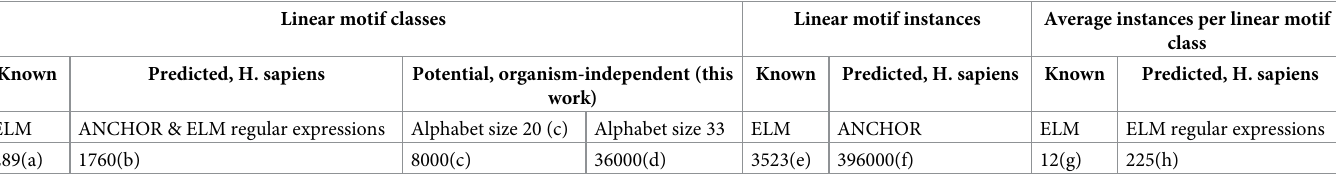
Table 2. Number of motif and instances from different sources. (a) Manually curated linear motif classes in the ELM database [3]. (b) Calculated from (f) and (h). (c) This work, Fig 4. (d) This work, Fig 5. (e) Manually curated linear motif instances in the ELM database [3]. (g) Calculated from (a) and (e). (f) Estimated using the ANCHOR algorithm for sequence-insensitive motif detection [9]. (h) Estimated by performing sequence searches using regular expressions and applying empirical filters to the results